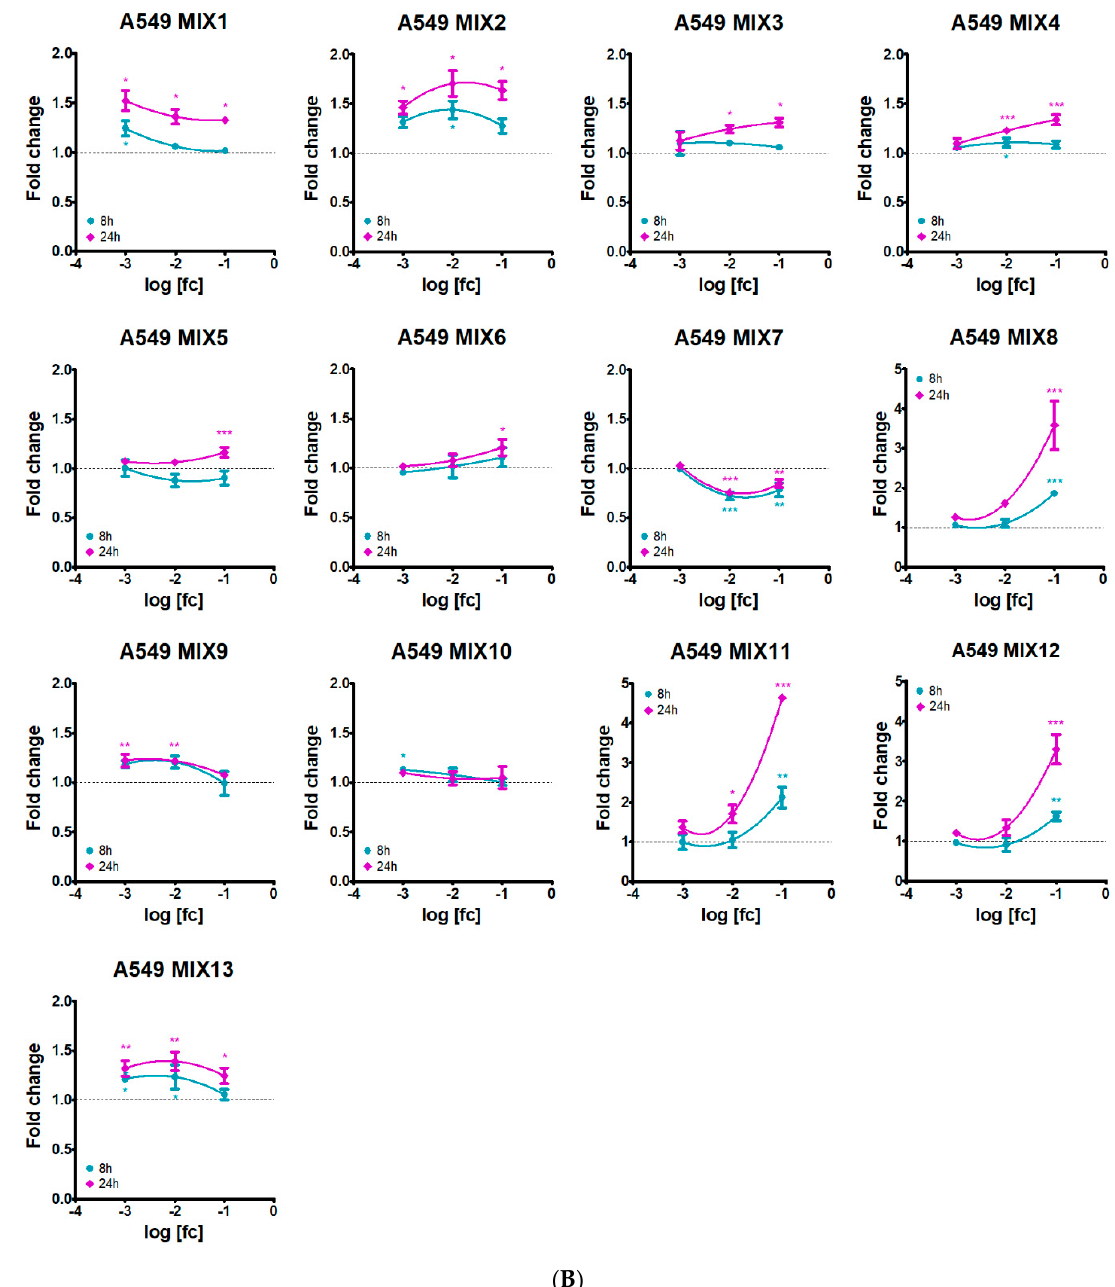
Figure 2. Dose-response curves of apoptosis assessment in ( A ) HepG2 and ( B ) A549 cell lines treated with the 13 pesticide mixtures for 8 h (dark turquoise lines) and 24 h (dark magenta lines). Concentrations are expressed as log of the field concentration [fc] dilution applied. Data represent mean fold change luminescence signals, compared to control cells, of three independent experiments. Asterisks indicate the level of significance: * p < 0.05; ** p < 0.01; *** p < 0.001.